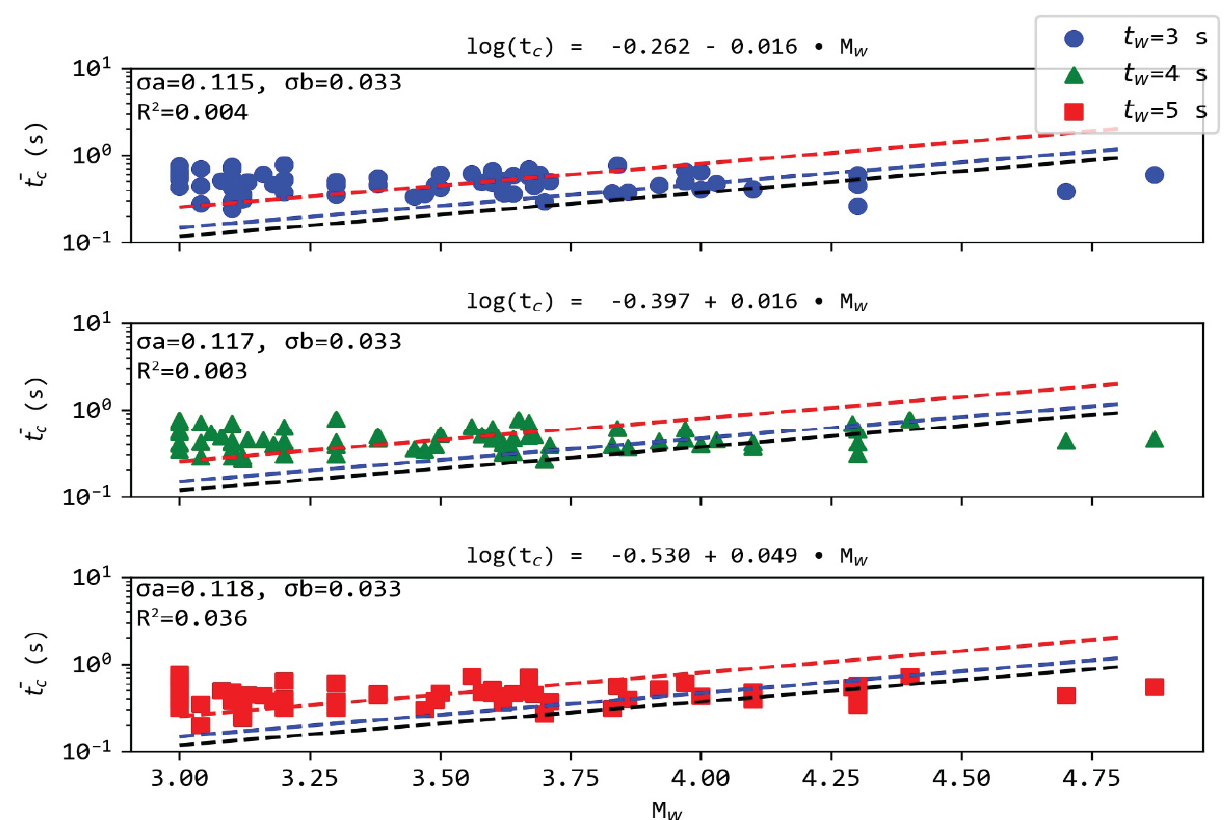
Figure 7. The characteristic period τ c estimated for different magnitudes M. The dashed lines are the theoretical expressions for stress drop 1 (red), 5 (blue) and 10 (black) MPa, respectively. The rest of the notation as in Figure 3.